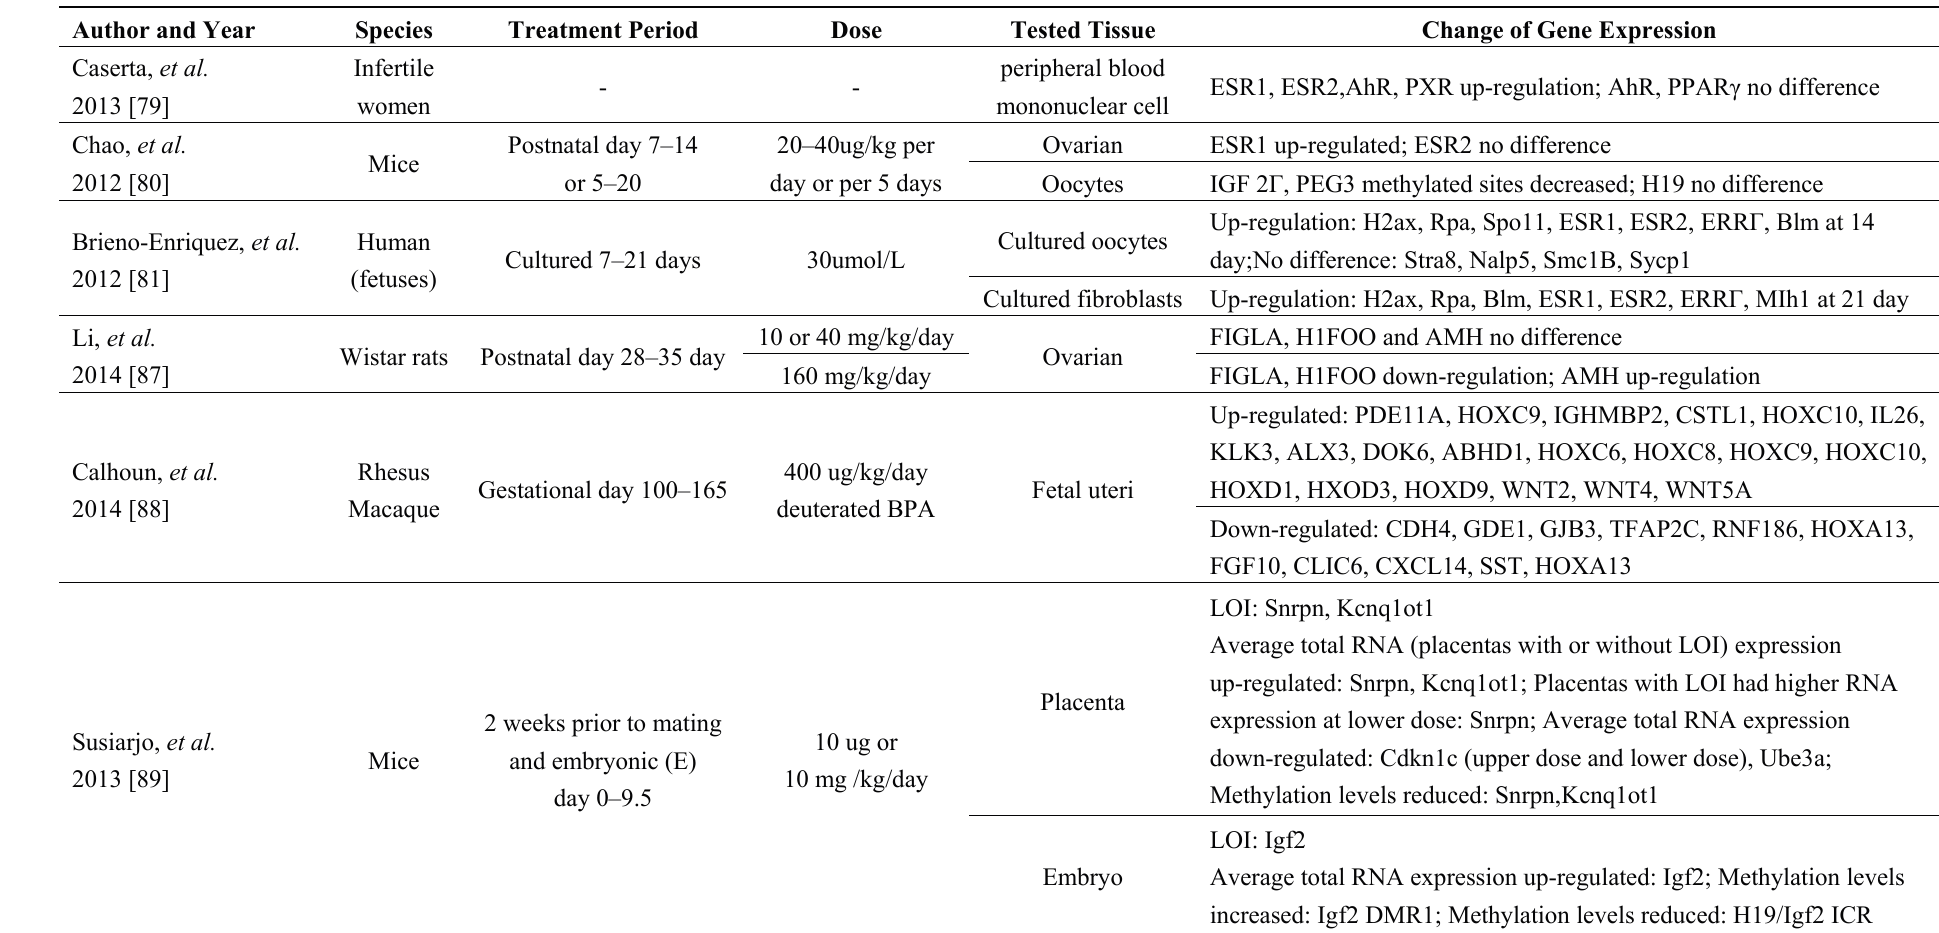
Table 1. BPA exposure and fertility related gene expression and genetic